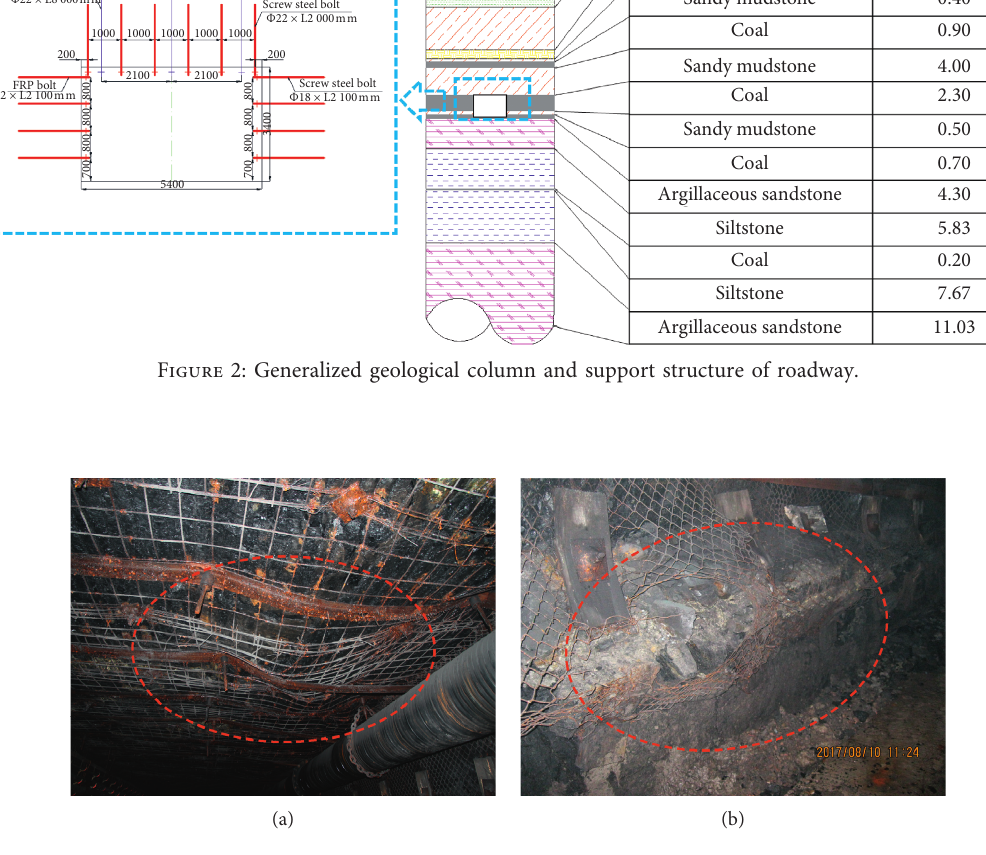
Figure 3: Deformation and failure diagram of surrounding rock on-site. (a) Roof falling. (b) Coal wall